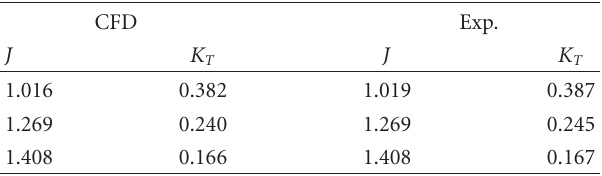
Table 6: Relative percentage errors for the PPTC propeller. J σ n